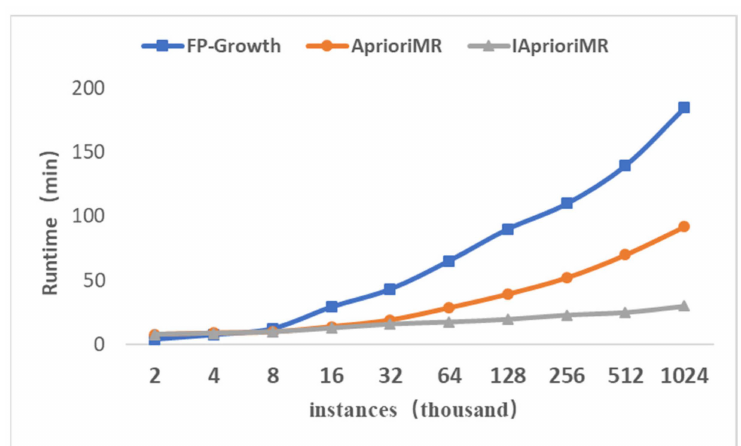
Figure 1. Diagram of the IAprioriMR algorithm.